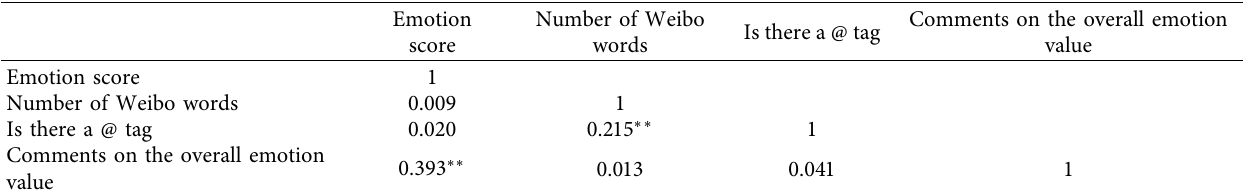
Table 8: Analysis of the correlations between Weibo antisocial emotion and the overall emotion value of comments.